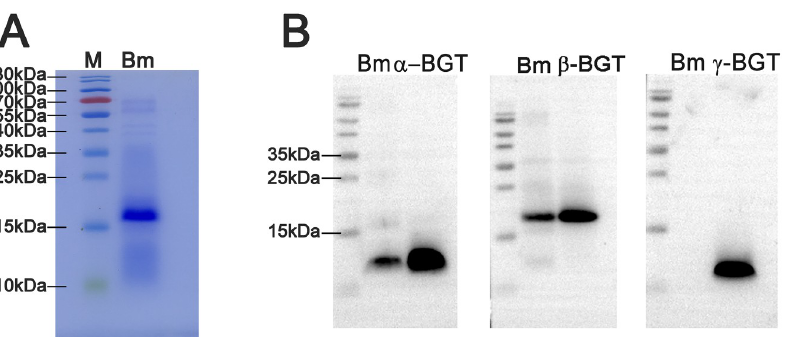
Fig 2. Specificity of three prepared antisera. SDS-PAGE of B . multicinctus venom under non-reducing conditions, 25 μ g/sample (A). Western-blot profile of prepared anti- α -BGT, anti- β -BGT and anti- γ -BGT antisera against crude venom and corresponding bungarotoxins (B). For Western-blot, 2 μ g of crude venom or purified neurotoxins were added in each lane. Bm: Crude venom of B . multicinctus